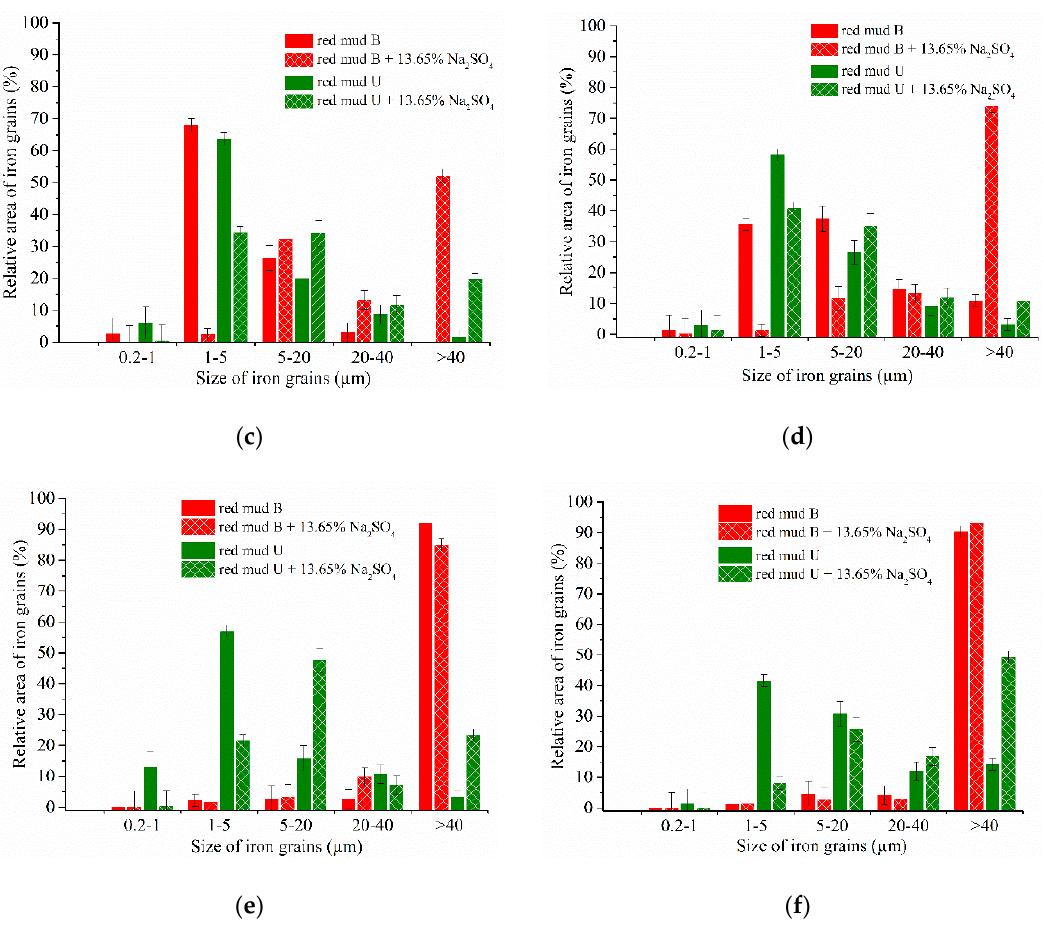
Figure 7. Effect of 13.65% Na 2 SO 4 addition to the samples B and U on the relative area of iron grains of different fractions after 180 min of roasting at 1000 ◦ C ( a ), 1100 ◦ C ( b ), 1150 ◦ C ( c ), 1200 ◦ C ( d ), 1250 ◦ C ( e ), 1300 ◦ C ( f ).